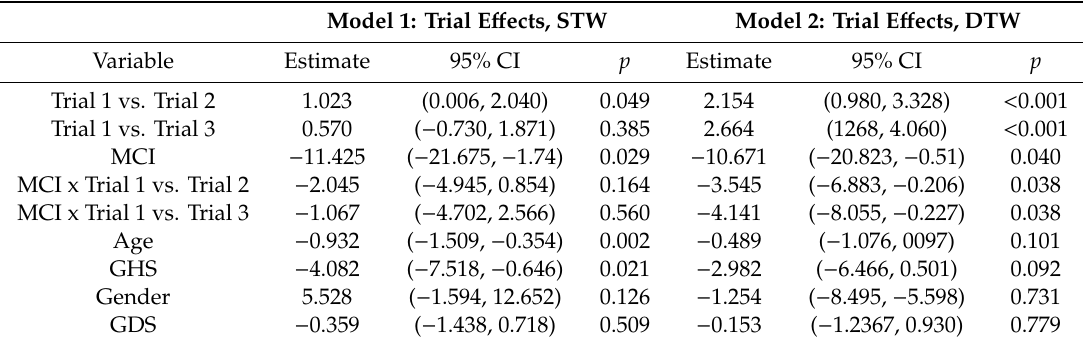
Table 3. Linear-Mixed-Model Estimates of Trial E ff ects on Gait Velocity in STW and DTW.